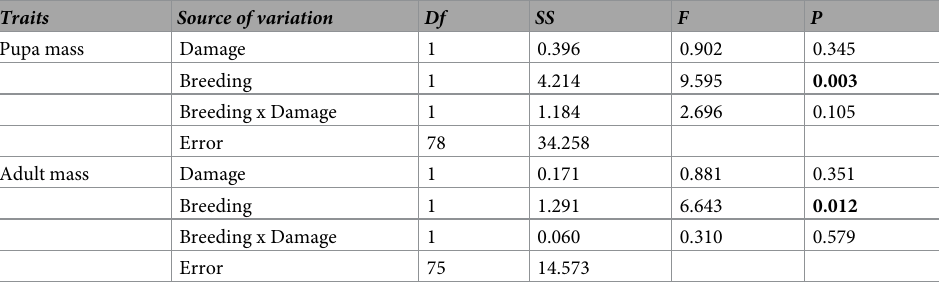
Table 2. Linear mixed-effects ANOVA for the effects of maternal herbivory (damage), maternal breeding, and their interaction on pupa and adult mass of M . sexta feeding on offspring of S . carolinense in the whole plant feed- ing